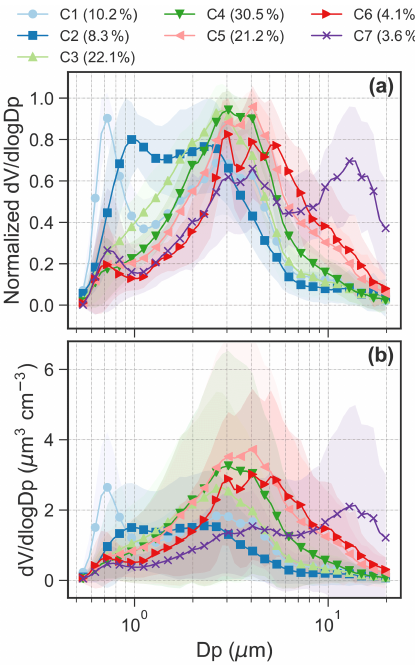
Figure A3. Average aerosol size distribution of the seven clusters using a seven-cluster solution.